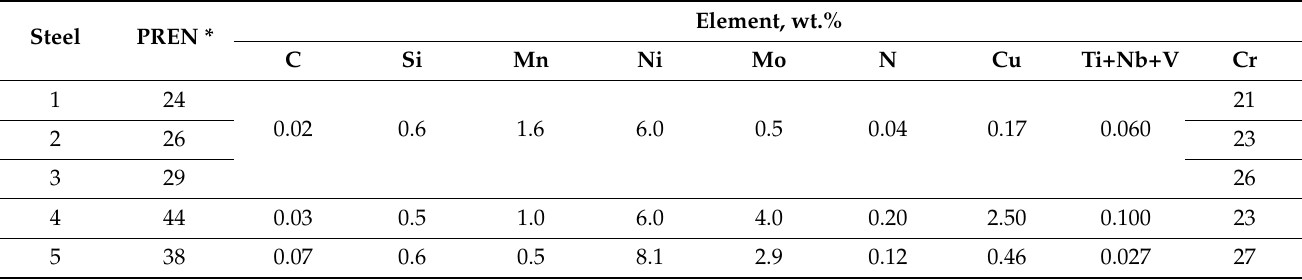
Table 1. Chemical compositions of experimental steels. Element,